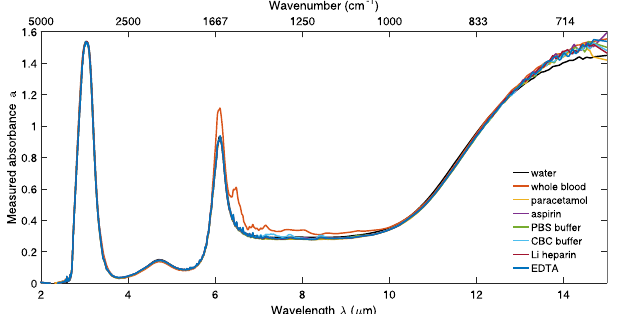
Figure 1. Absorbance spectra of DI water, whole blood and aqueous solutions of paracetamol, aspirin, heparin, EDTA, PBS and